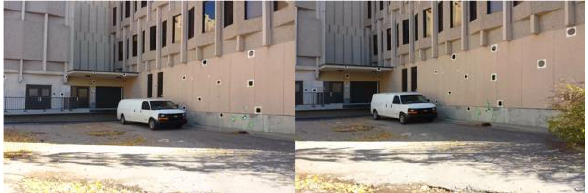
Figure 6. Two selected images of the recorded video